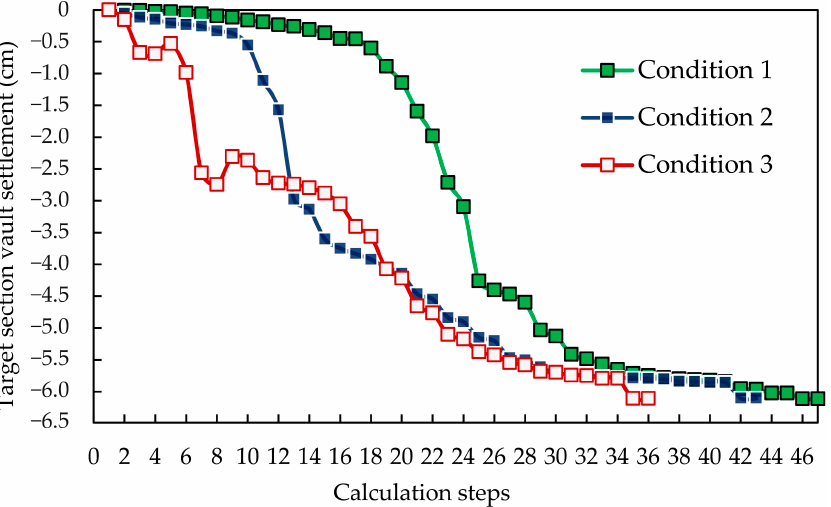
Figure 8. The vertical settlement variation curve of the vault at the target section in different calculation steps.